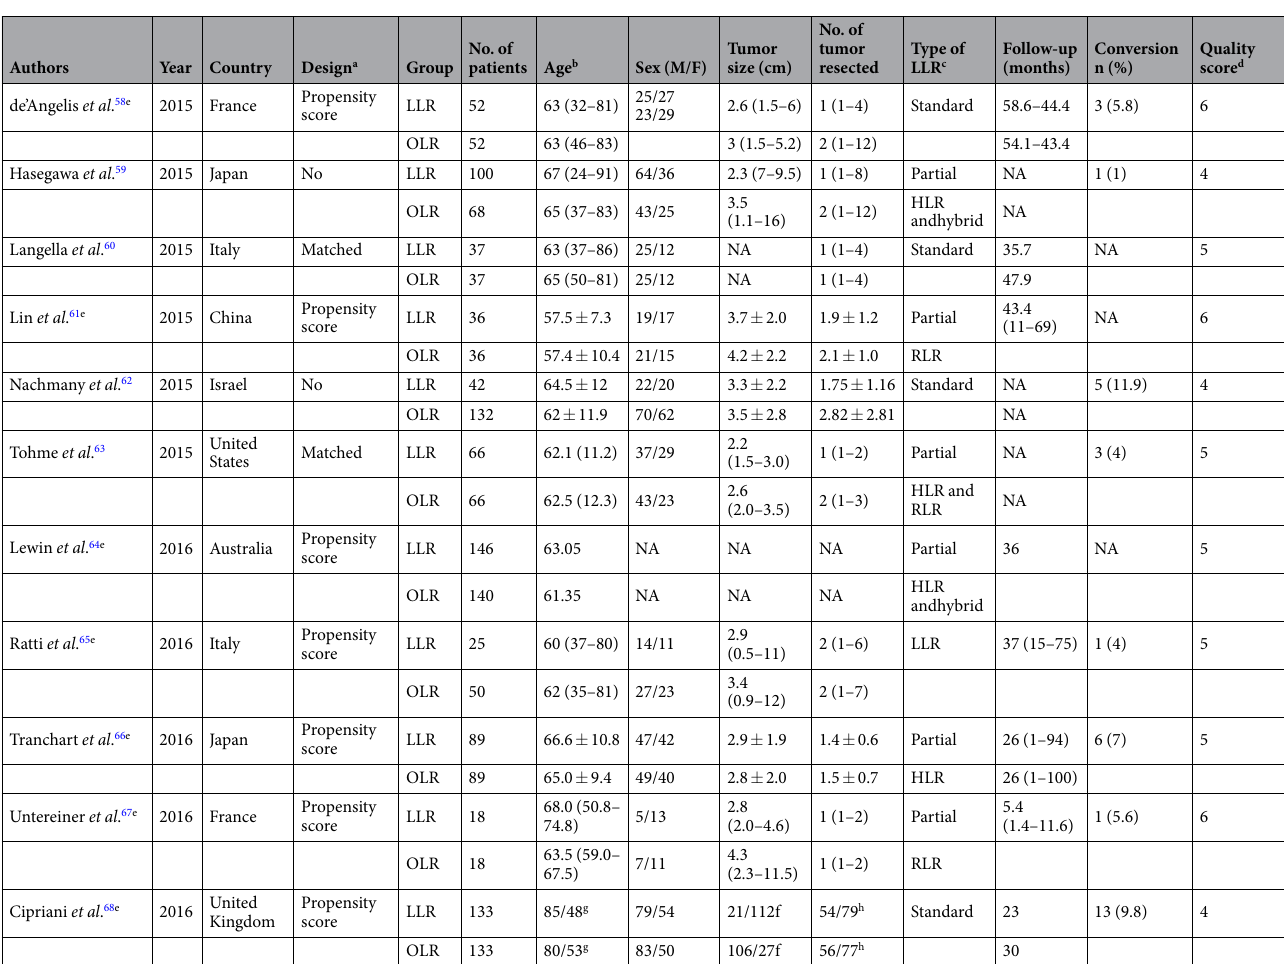
Table 1. Characteristics of the included studies. LLR : laparoscopic liver resection, NA : not available, HLR : hand-assisted liver resection, RLR : robotic-assisted liver resection. a All studies were retrospective observational study. b Age is expressed median (range), mean ± standard deviation, median, or mean. c Some studies included a portion of LLR managed with HLR, RLR, or hybrid. d Assessed by modified Newcastle-Ottawa Scale. e Data were analyzed from prospective databases in these studies. f No. of patients with tumor size < 5 and ≥ 5 cm. g No. of patients with age ≤ 70 and > 70 years. h No. of liver lesions: single or multiple. i No. of liver lesions:1 or 2–4 or ≥ 5. j No. of liver lesions:1 or ≥